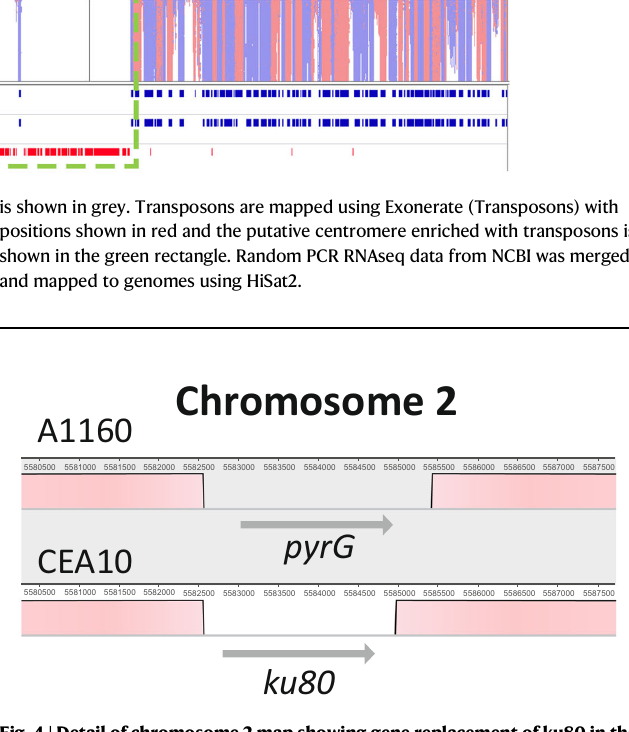
Fig. 4 | Detail ofchromosome 2 mapshowing gene replacementofku80in the A1160 strain with reference to the parental CEA10 isolate. The native CEA10 ku80 gene was replaced with a pyrG marker during construction of A1160 10